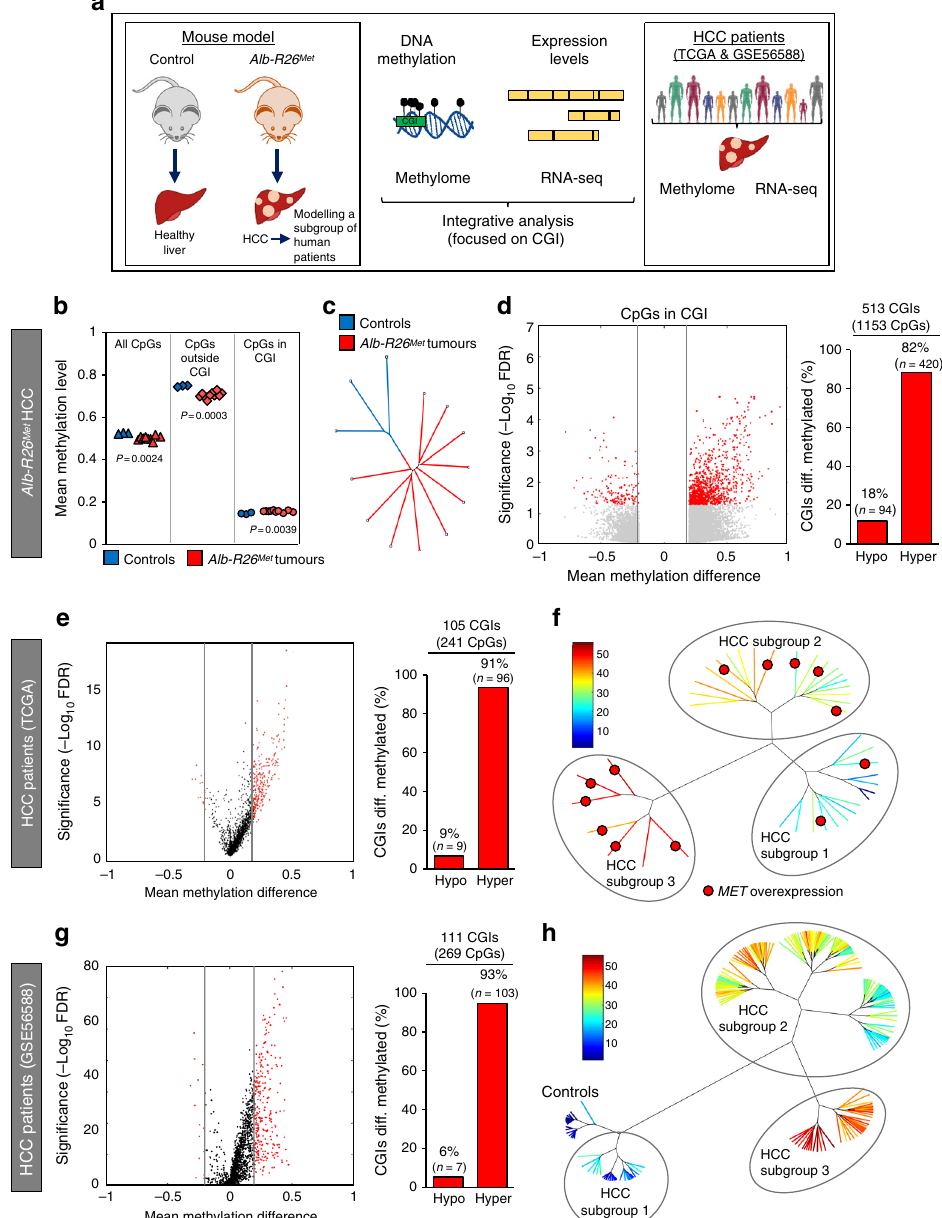
Fig. 1 Methylome studies identify an enrichment of CGI hypermethylation in Alb-R26 Met tumours, also present in a subset of HCC patients. a Schematic representation of the overall strategy employed. DNA methylation and gene expression levels were analysed in Alb-R26 Met tumours and control livers. Outcomes were compared with HCC human database. b Mean methylation levels in controls and Alb-R26 Met tumours, focusing on all CpGs, CpGs outside CGIs and CpGs in CGIs. c Unrooted distance tree using the overall DNA methylation content subdivides Alb-R26 Met tumours and controls in two distinct clusters. d Volcano plot reporting methylation differences with signi fi cance (expressed as − Log 10 FDR) for CpGs in CGIs in Alb-R26 Met tumours versus control (left). Signi fi cant differences (methylation difference > 0.2 and FDR < 0.05) are shown in red. Graph reporting the percentage (and numbers) of hypomethylated versus hypermethylated CGIs (right). e Volcano plot reporting the mean methylation differences with signi fi cance (expressed as − Log 10 FDR) in HCC patients from TCGA (left) for differentially methylated CGIs identi fi ed in Alb-R26 Met tumours. Similar methylation levels in HCC patients and controls are reported in black, whereas changes (>0.2) are reported in red. On the right, the graph reports the percentage (and numbers) of hypomethylated versus hypermethylated CGIs. f Unrooted distance tree of the 41 TCGA HCC patients showing patient segregation in three distinct subgroups, according to the 416 CGIs found differentially methylated in Alb-R26 Met tumours. Red dots highlight patients in which MET is overexpressed (log 2 FC > 1). Patients are reported in different colours according to the percentage of overlap (the scale in percentage is shown on the left). Note the striking correlation between differentially methylated CGIs and MET overexpression in the HCC patient subgroup 3. g , h Volcano plot ( g ) and unrooted distance tree ( h ) from studies using a second cohort of 224 HCC patients and 10 controls (GSE56588